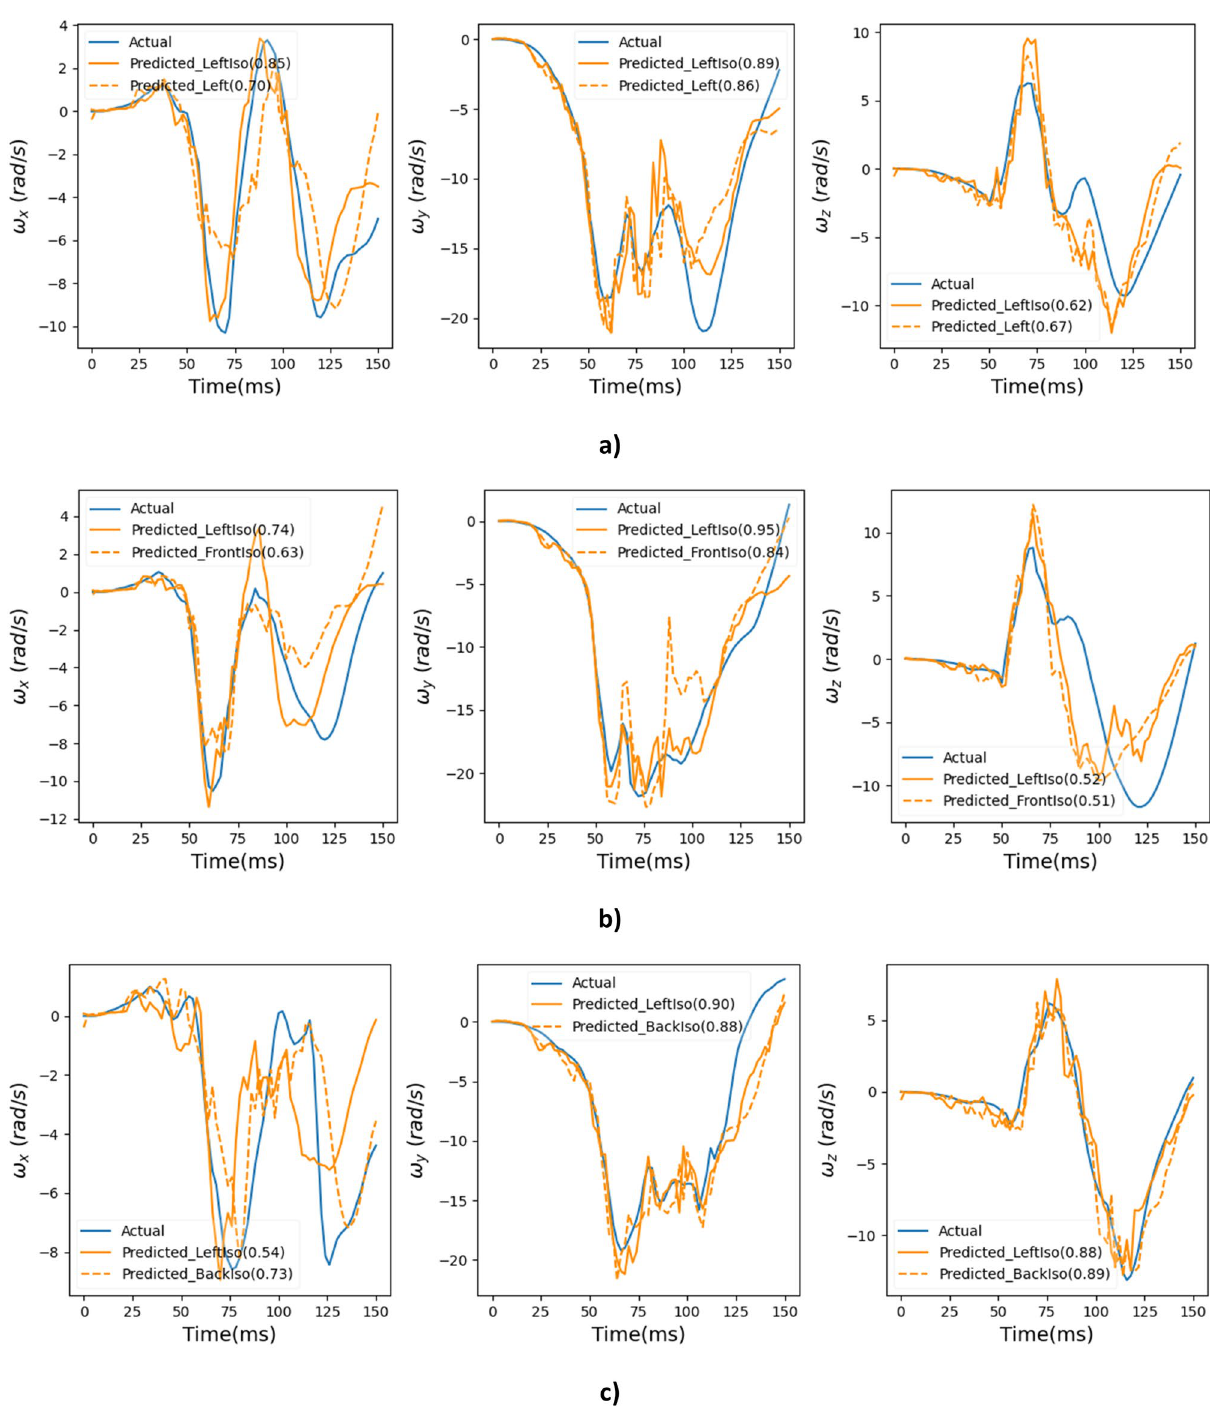
Figure 15. Angular velocity time history comparison: ( a ) left and left isometric views (Crash pulse—NHTSA test 8035), ( b ) left isometric and front isometric views (Crash pulse—NHTSA test 9010), and ( c ) left isometric and back isometric views (Crash pulse—NHTSA test